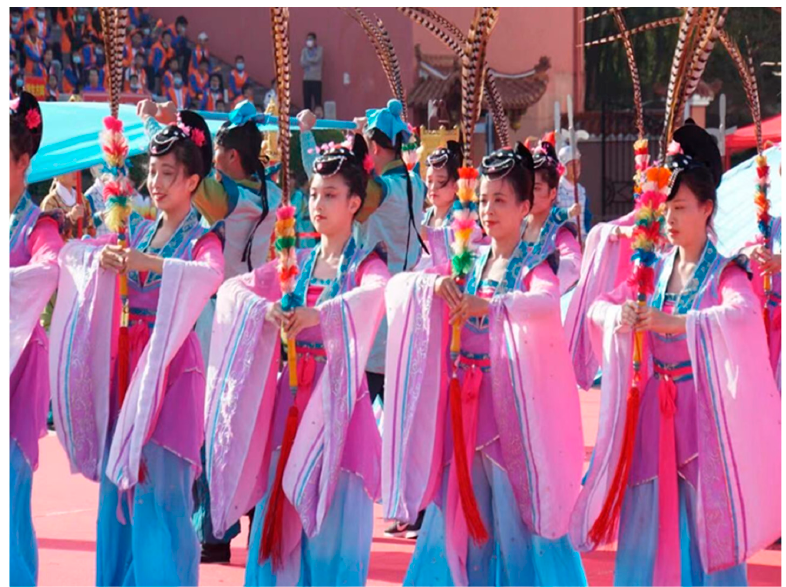
Figure 4. Female dancers performing yuewu. Source: the website of Meizhou ancestral temple